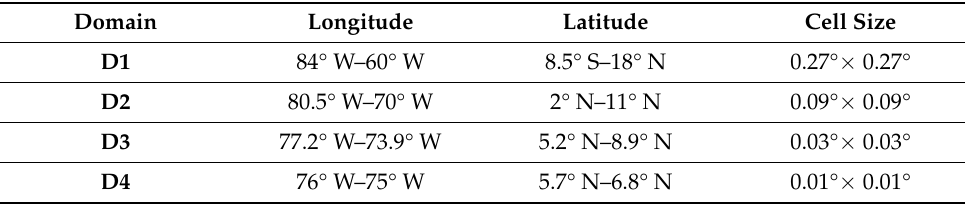
Figure 2. Nested domain configuration for LOTOS-EUROS simulations. The detailed description of the domains is shown in Table 1. Table 1. One-way nested domain configuration used for simulations in LOTOS-EUROS. All data assimilation experiments were conducted in